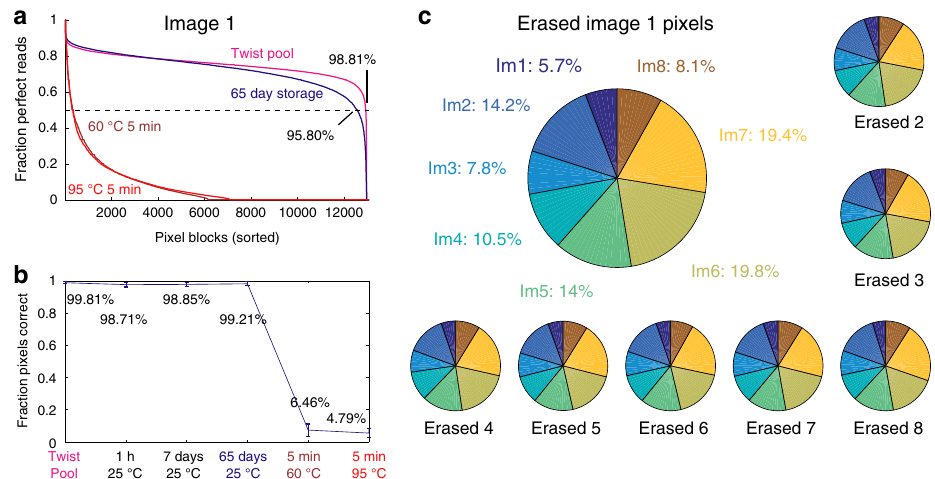
Fig. 5 Analysis summary of image reconstruction and erasure completeness. a Fraction of NGS reads mapped to each pixel block with expected sequence. The four different colored traces correspond to the different storage/erasure conditions. b Summary of fraction of pixels correctly restored for different storage/erasure conditions. Here, a pixel is considered to be correctly read if at least 50% of the decodable NGS reads at its address correspond to the expected sequence. The error bars show one standard deviation for the N = 8 separate restored images. c Distribution of best-match pixels for each erased image shown in Fig. 4b. For example, 14.2% of the erased Image 1 pixels have a consensus sequence that matches Image 2. A different fraction of pixels match best to each of the eight reference images, likely due to differences in initial concentrations of oligos from either the Twist pool or due to biased PCR ampli fi cation. All eight erased images have similar distributions of best-match pixels, suggesting that erasure is complete and images cannot be